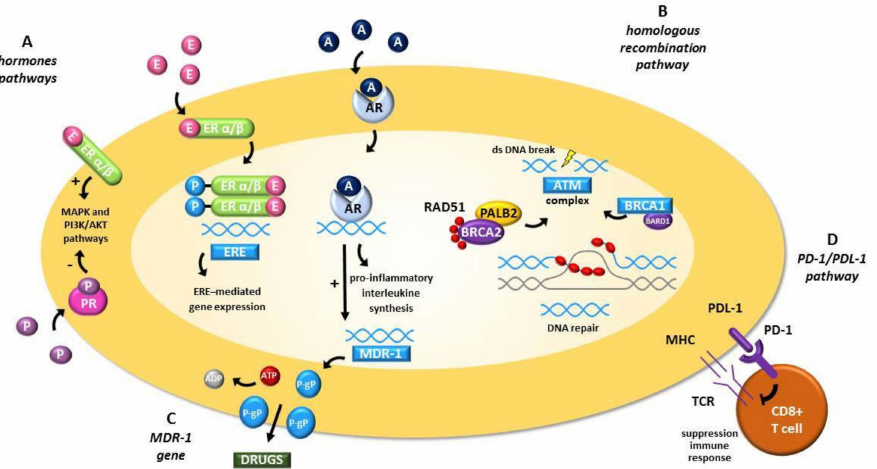
Figure 1. Pathways and proteins identified in brain metastasis from ovarian cancer. ( A ) Hormones pathway. Effects of estrogens are mediated by activation of nuclear receptors, the estrogen receptor- α (ER- α ), and estrogen receptor- β (ER- β ). The complex estrogen and ER α / β , phosphorylated and dimerized, moves into the nucleus and activates transcription of a battery of genes (ERE-genes), which stimulate cell proliferation. However, complex estrogen-ER, through transmembrane protein, activates the MAPK and PI3K/AKT pathway. Indeed the association progesterone and PR, regulates these pathways. Finally, AR causes the synthesis of pro-inflammatory interleukins (IL-6 and IL-8) and activates the ABC transporters expression, as MDR-1. ( B ) Homologous recombination pathway . The complex ATM recognizes dsDNA break and recruits complex BRCA1 and BRCA2, blocking the replication fork. RAD51 forms a nucleoprotein filament that mediates homologous pairing to the sister chromatid to repair the dsDNA break. ( C ) MDR-1 gene . P-glycoprotein (P-gp), the product of the MDR1 gene, is an ATP-binding cassette (ABC) efflux transporter. This pump can efflux cytotoxic agents using ATP driven energy. ( D ) PD-1/PD-L1 pathway . The interaction between PD-1 on CD8 positive T cell and its ligands PD-L1 on tumor cell inhibits TCR signalling, leading to reduced T cell proliferation and cytokine production and increasing susceptibility to apoptosis. Legend. E: estrogen; ER: estrogen receptor; ERE: estrogen responsive element; P: progesterone; PR: progesterone receptor; A: androgen; AR: androgen receptor; IL: interleukin; MDR: Multi drug resistance; P-gp: P-glycoprotein; TCR: T cell receptor; ABC: ATP-binding cassette; MHC: major histocompatibility